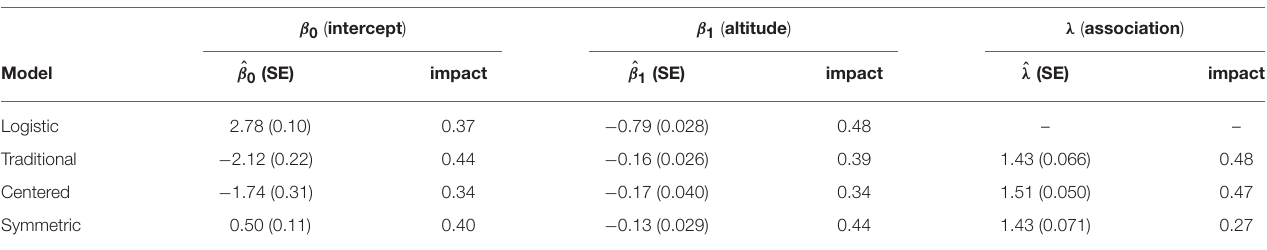
TABLE 1 | Parameter estimation results for the H. vulgaris